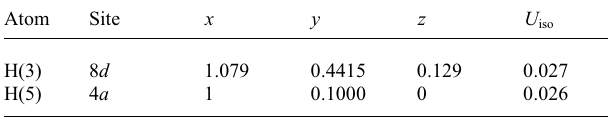
Table 2. Atomic coordinates and displacement parameters (in Å 2 ) .